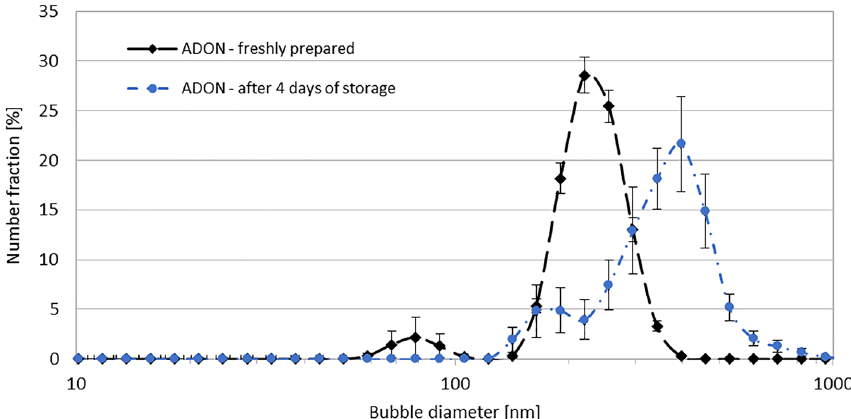
Figure 2. Densities of number size distributions of nanobubbles directly after generation and after 4 days of storage. ADON aqueous dispersions of oxygen nanobubbles.